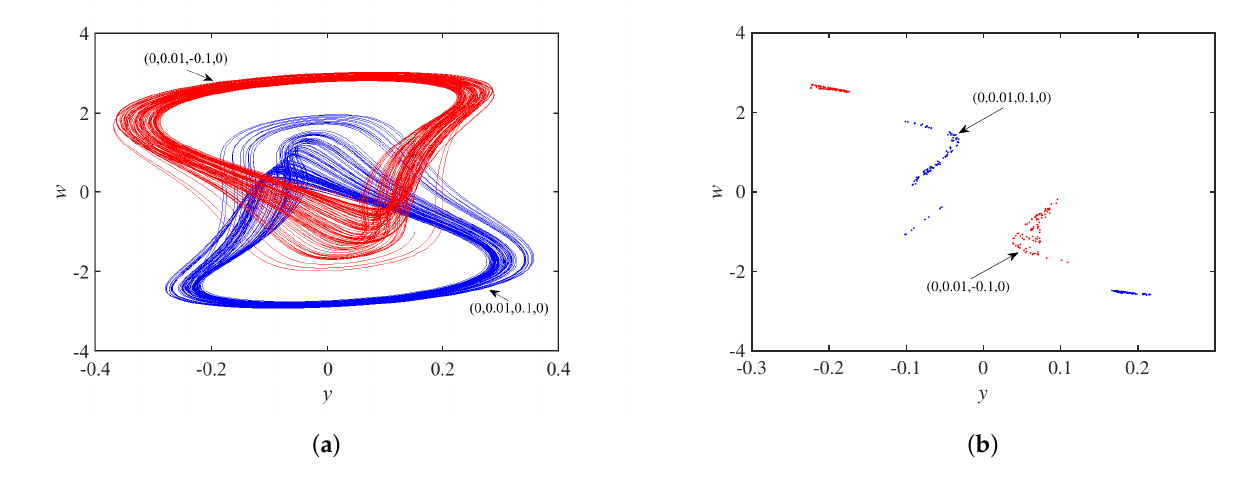
Figure 12. Dynamics behavior with initial state u 3 ( 0 ) : ( a ) coexisting single-scroll attractors; ( b ) Poincaré maps.